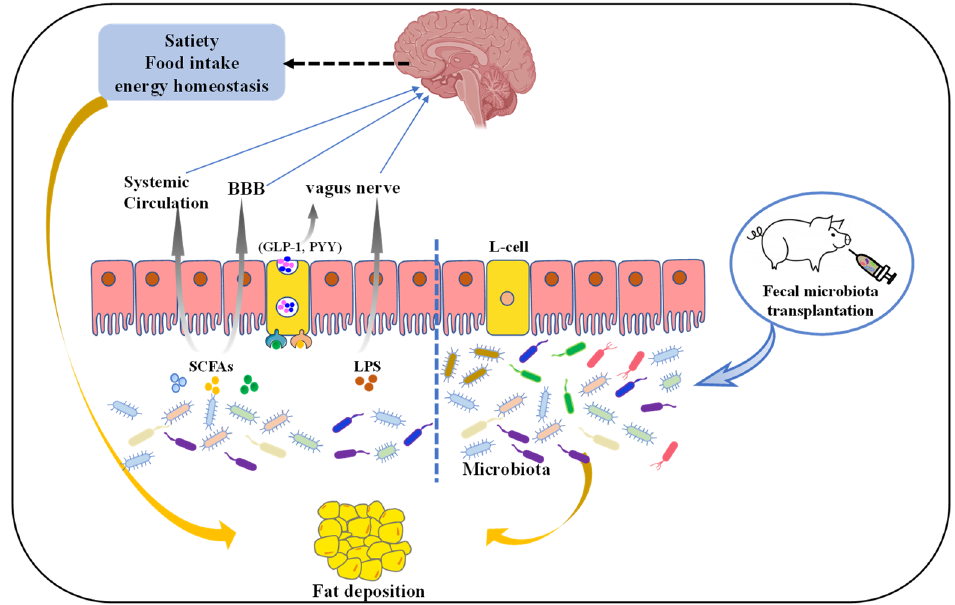
Figure 1. The mechanism of gut microbiota regulates pig fat deposition. Microbiota-derived metabolites such as SCFAs or lipopolysaccharide (LPS) affect satiety, food intake, or energy homeostasis directly via the vagus nerve (VN) or indirectly blood–brain barrier (BBB) and systemic circulation. L-cells are activated by these microbial metabolites through activation of different receptors, resulting in the production of gut hormones such as glucagon-like peptide-1 (GLP-1) and peptide YY (PYY). These intestinal hormones signal from the gut to the nucleus tractus solitarius in the brain via the VN and direct secretion into the circulatory system. Additionally, fecal microbiota transplantation (FMT), where fecal microbiota from a donor is transplanted into a recipient GI tract, has the potential to be an effective option to regulate fat deposition.